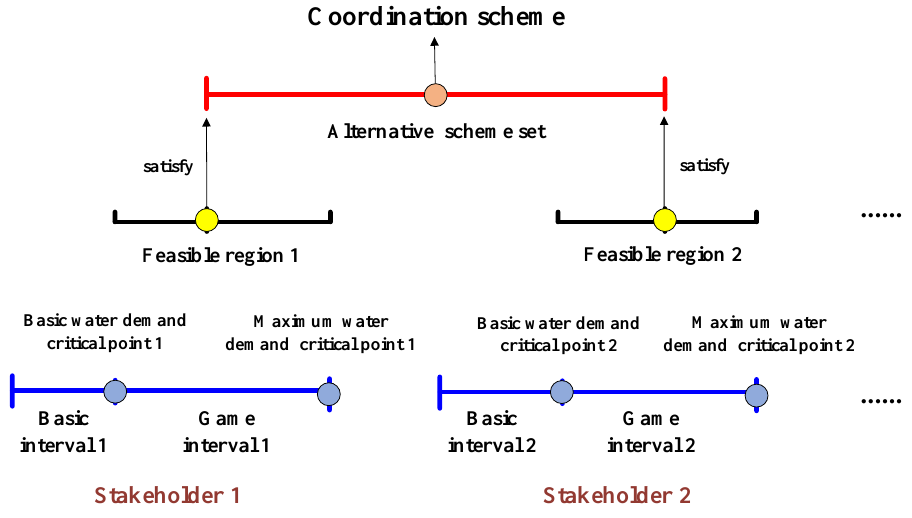
Figure 2. Sketch map of the multi-stakeholder interval coordination mechanism.